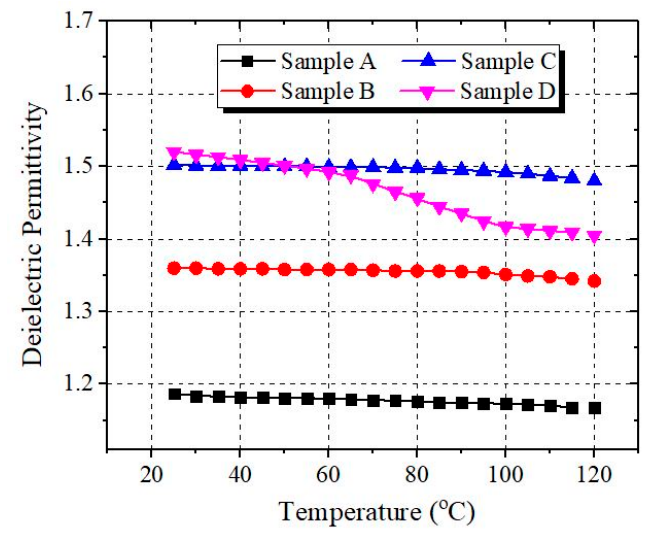
Figure 12. Permittivity of oil samples at various temperatures.